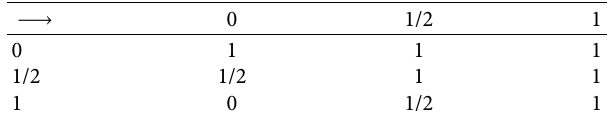
Table 1: Lukaswize truth table.